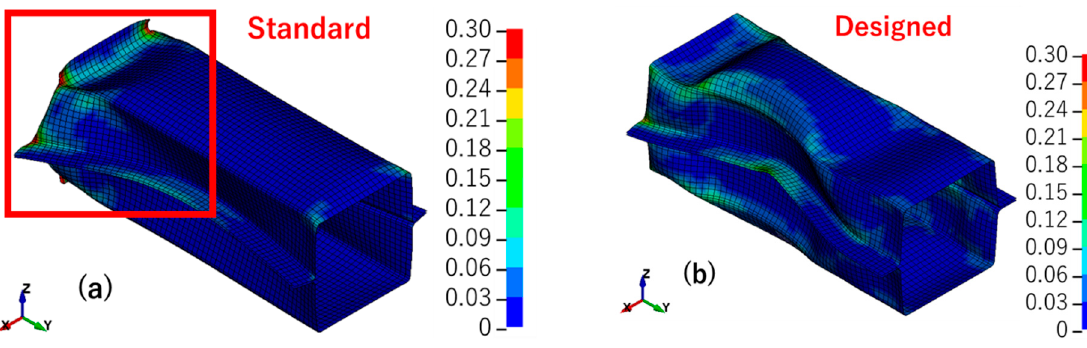
Figure 10. Von Mises effective stress: ( a ) standard model; ( b ) designed model.